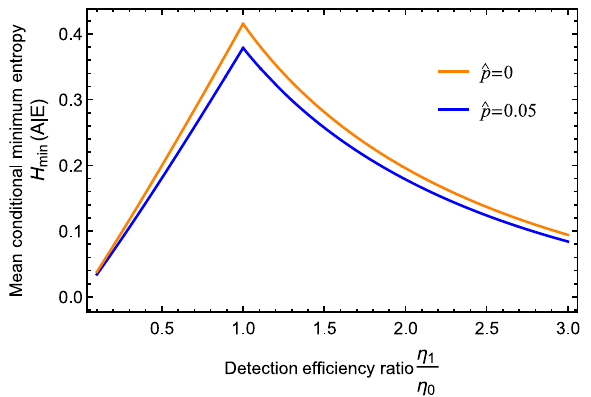
Fig. 4 The relation between H min ( A ∣ E ) and η 1 η 0.05). The pulses with a Poisson distribution that contains ν = 10 photons insert SPDs with η α = 0.1 and e d = 6 × 10 − 7